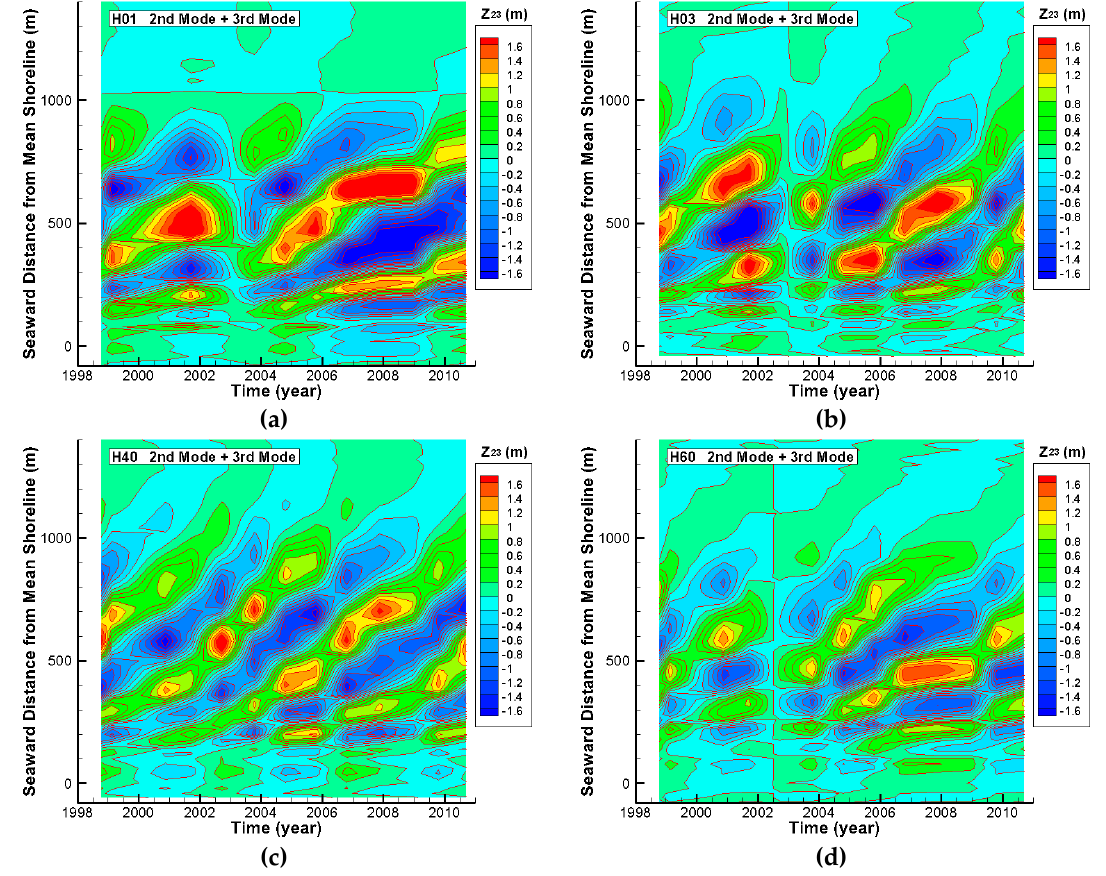
Figure 18. Reconstructed variation by the superposition of the second and third modes ( Z 23 = C 2 e 2 + C 3 e 3